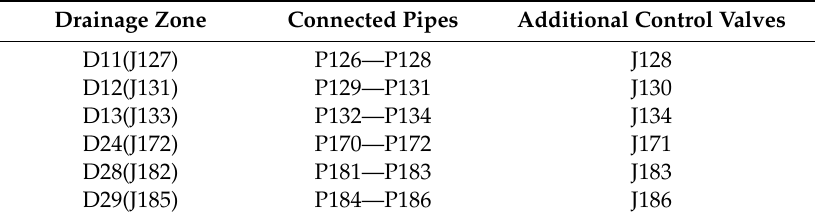
Figure 7. Drainage time: ( a ) before installing additional control valves; ( b ) after installing additional control valves. control valves. Table 5. Drainage zone for the control valves to be